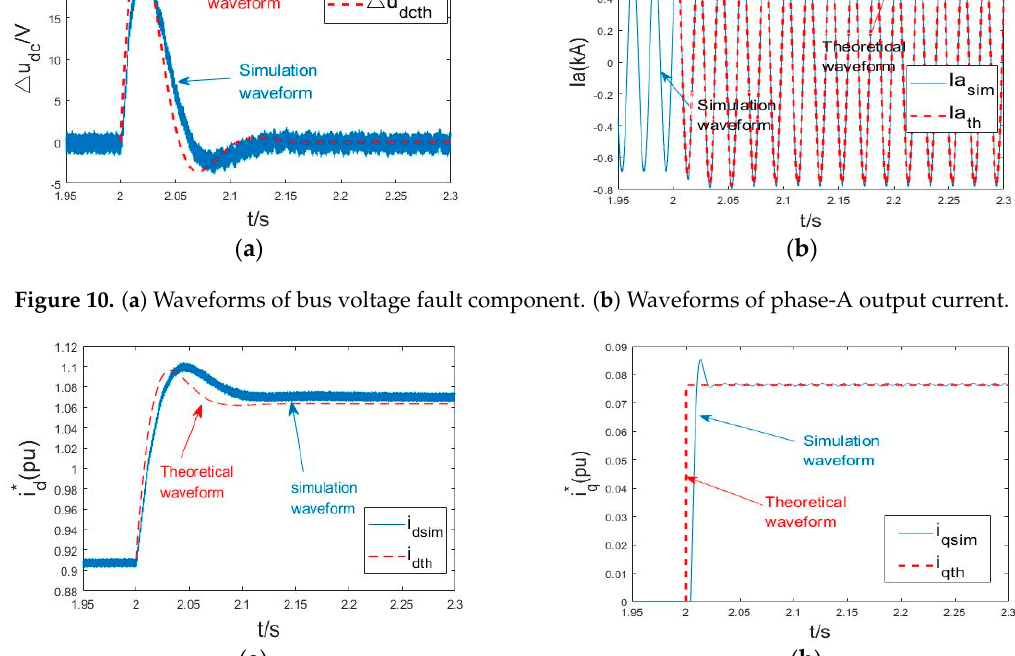
Figure 10. ( a ) Waveforms of bus voltage fault component. ( b ) Waveforms of phase-A output current.